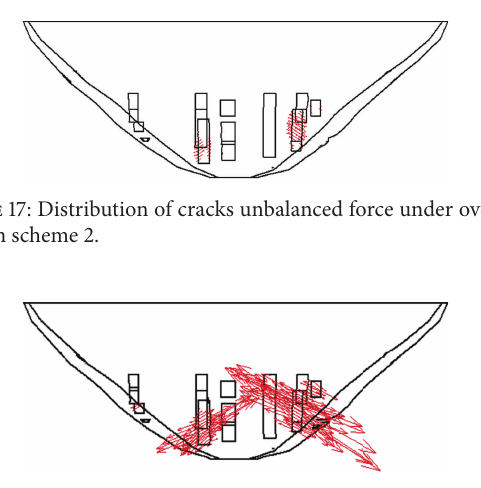
Figure 18: Distribution of cracks unbalanced force under overload 2.0𝑃 0 in scheme 3.